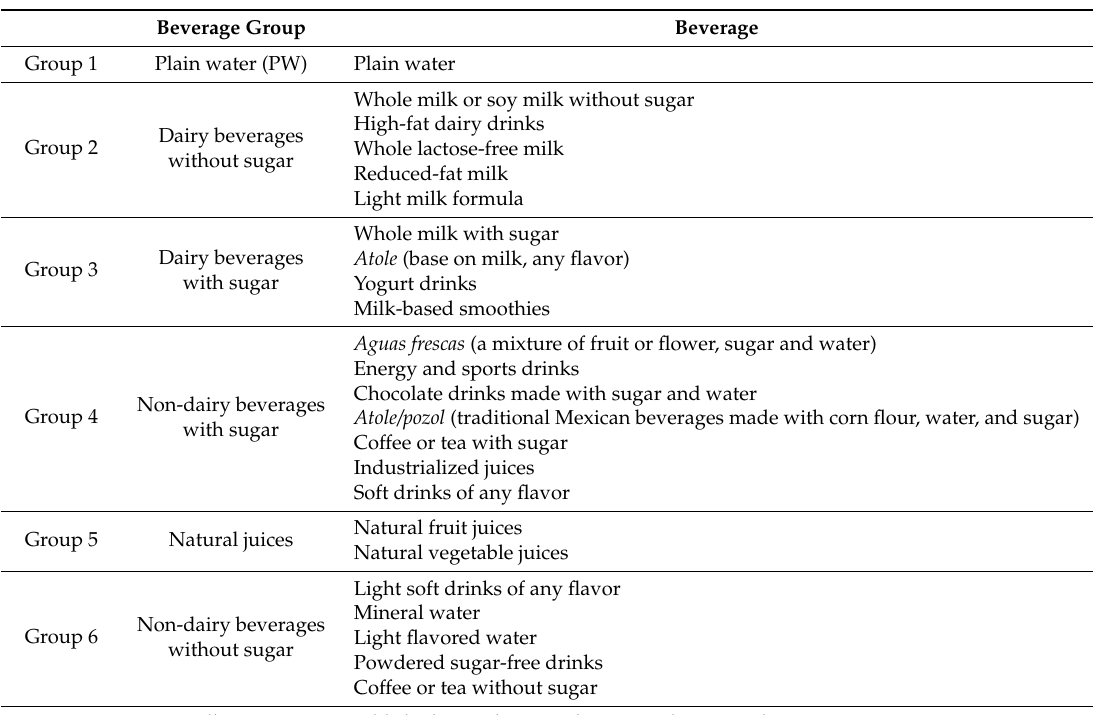
Table 1. Classification of beverage groups among Mexican school-age children (five to eleven years old), ENSANUT